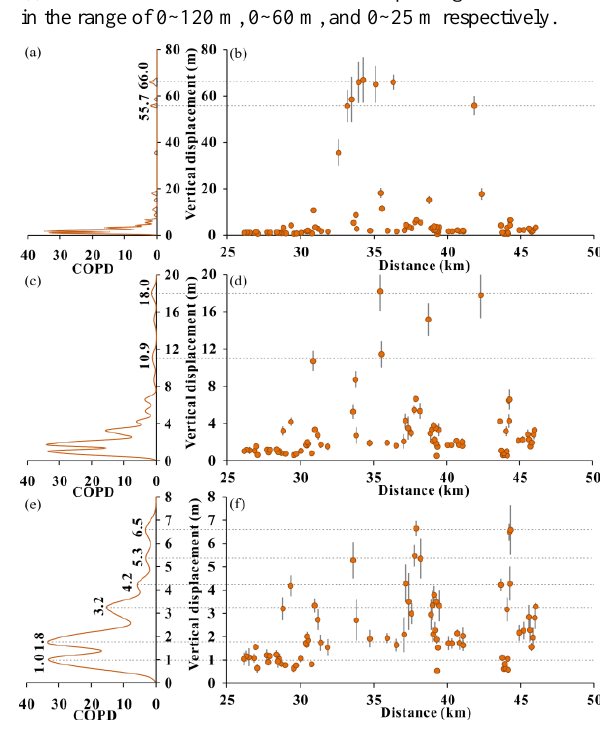
Figure 7. Strike slip on the south segment of the West Helanshan Fault. (a), (c), and (e) represent the cumulative offset probability density (COPD) plot of the strike slip in the range of 0~120 m, 0~60 m, and 0~25 m respectively. While (b), (d), and (f) denote the distribution of the strike slip along the fault strike in the range of 0~120 m, 0~60 m, and 0~25 m respectively.